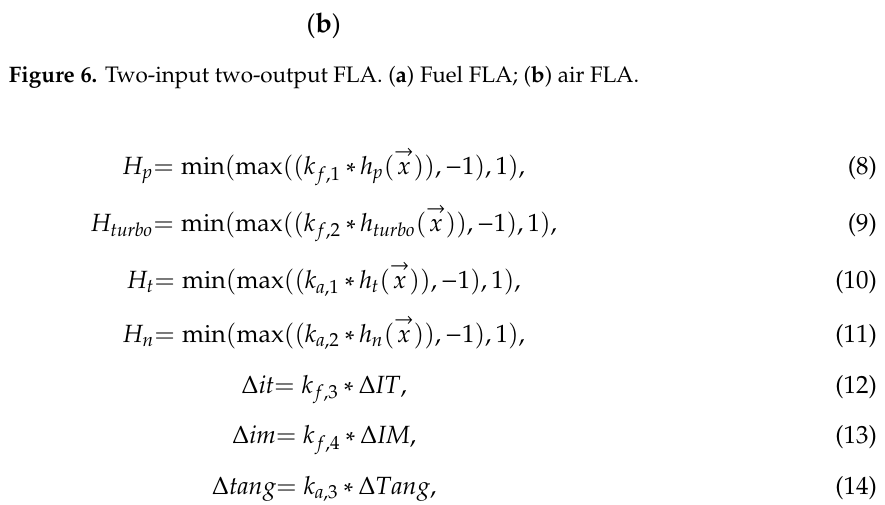
Figure 6. Two-input two-output FLA. ( a ) Fuel FLA; ( b ) air FLA.